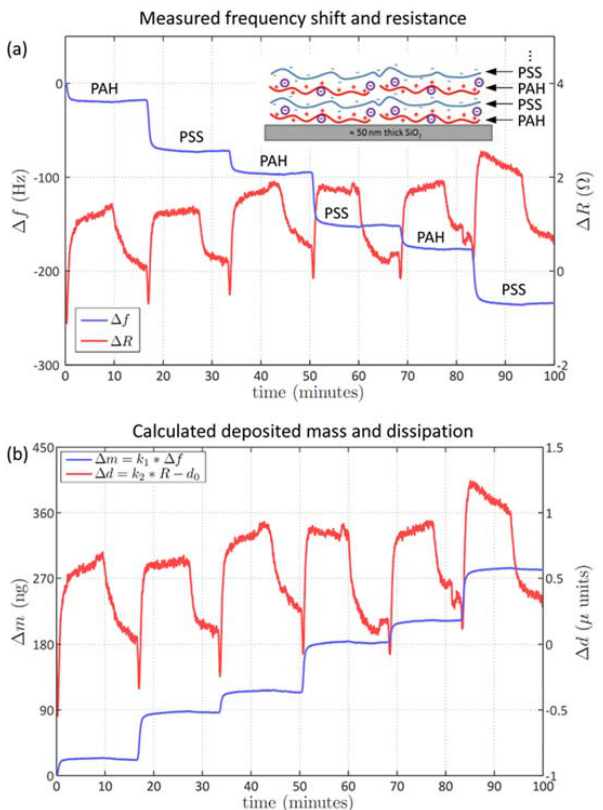
Figure 4. Impedance QCM measurement results of the formation of a polyelectrolyte multilayer (PEM) on top of a silicon dioxide coated quartz crystal (5 MHz resonance frequency). ( a ) Experimental data showing the stepwise decrease in resonance frequency (left axis, third harmonic, not normalized) and resistance (right axis) due to the sequential injection of solutions of poly(allylammonium hydrochloride) (PAH, 1 mM) and poly(sodium styrene sulfonate) (PSS, 1 mM) in the presence of NaCl (0.5 M). A 10 point moving average filter was applied to the raw data. The polymer was injected for 10 min at a flow rate of 50 µL/min followed by a 5 min injection of 0.5 M NaCl solution; and ( b ) calculated mass uptake (left axis) per electrode area and dissipation values (right axis) for the individual polymer layers.